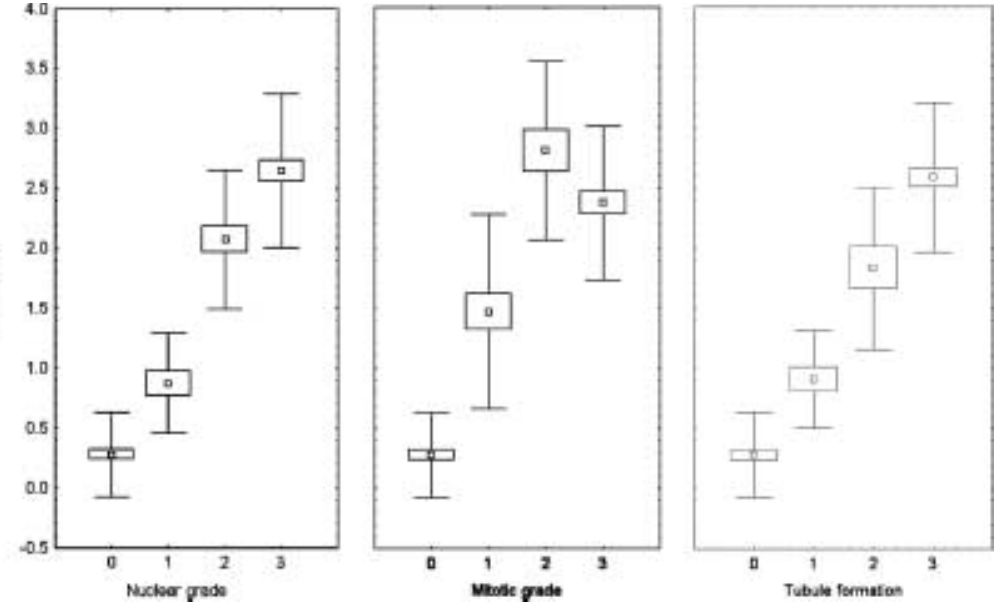
Fig. 5. Distribution of quantitative nuclear grade with respect to components of the Nottingham scoring system: nuclear grade, mitotic index, and degree of tubule formation. The boxes associated with each point represent the region ± 1 standard error from the mean, and the horizontal lines (whiskers) represent the region ± 1 standard deviation.